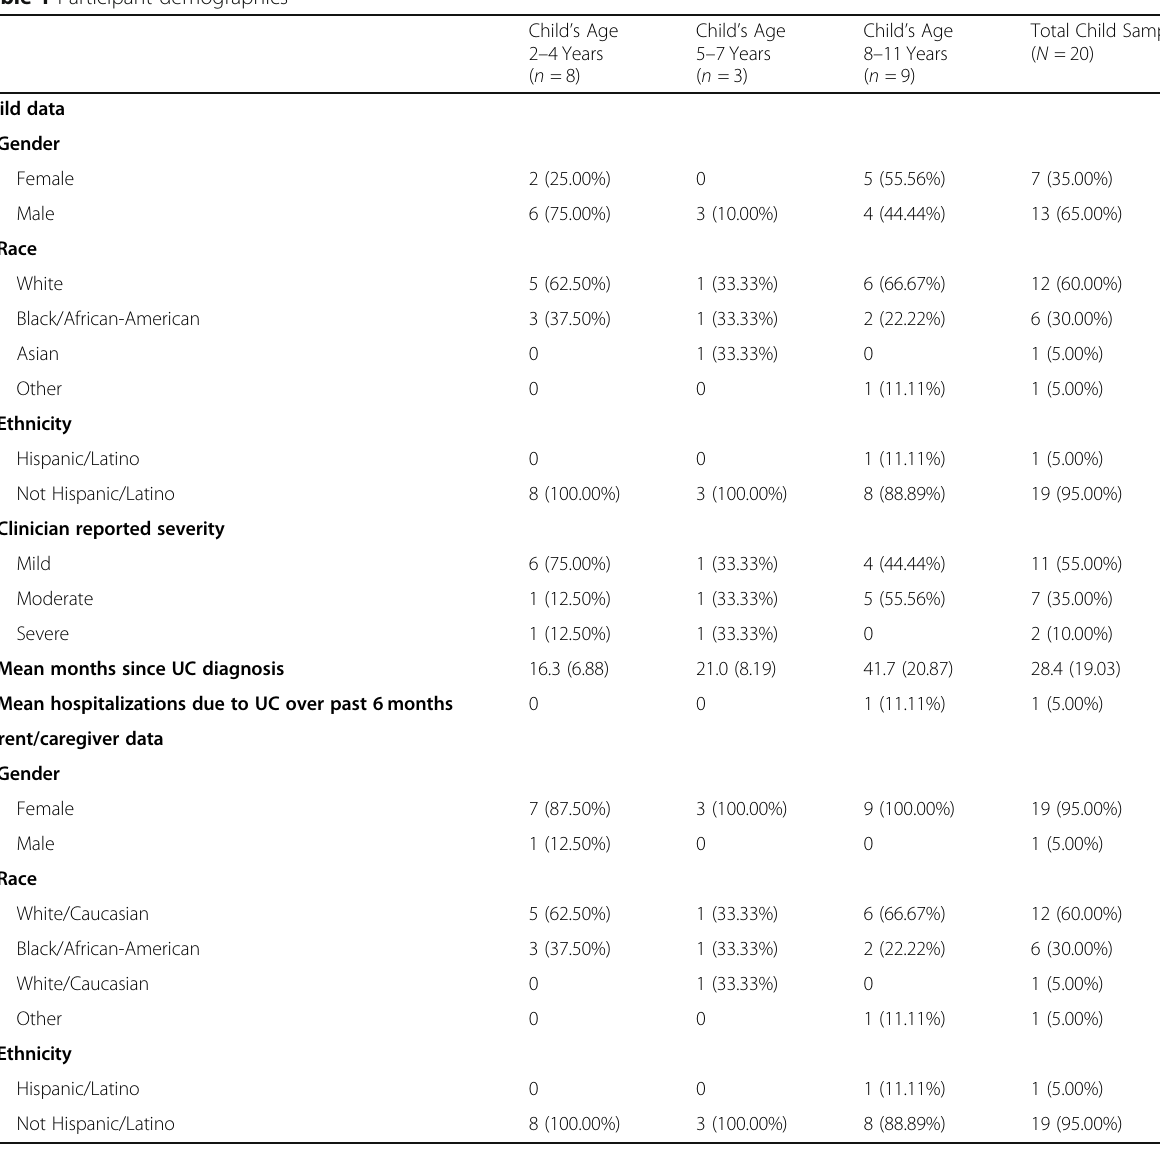
Table 1 Participant